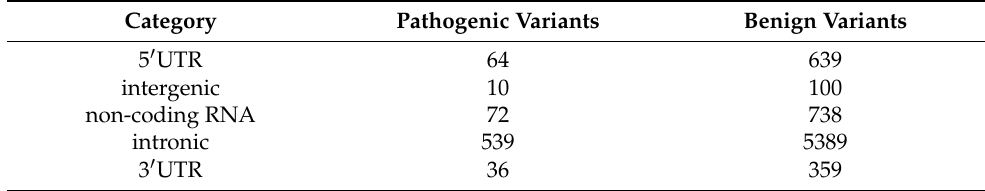
Table 1. Number of variants available in ncVarDB after conversion to